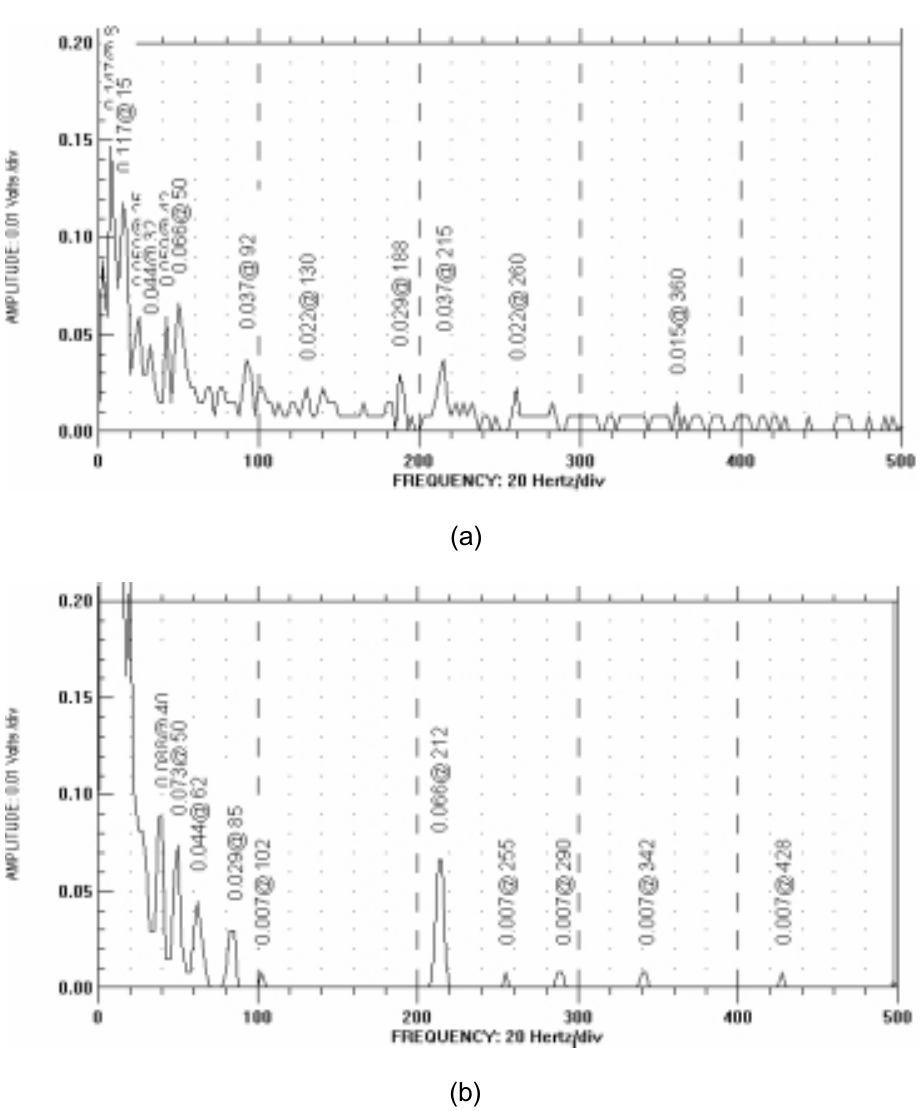
Fig. 33. Frequency spectrums of the steady-state vibrations of the system rotating at speed of 10 Hz with blade-to-stator rubbing: (a) Strain gages, (b) PZT material. 5 Hz and 18 Hz, with the highest amplitudes. The 1X frequency is seen in the spectrum together with the blade first bending natural frequency of 62 Hz, which is increased due to the stiffening effect. Also seen are the frequencies at 102 Hz and 138 Hz, 198 Hz and 265 Hz. The 198 Hz frequency is in the range of 200 Hz that was previously observed with the trend of getting lowered when the rotation speed is increased. All the frequency components appearing in the strain gage spectrum are captured by the PZT spectrum of Fig. 32(b). In addition, the PZT spectrum shows frequency components at 315 Hz, 368 Hz and 395 Hz related to the blade-disk system natural frequencies or to excitations of nonlinear